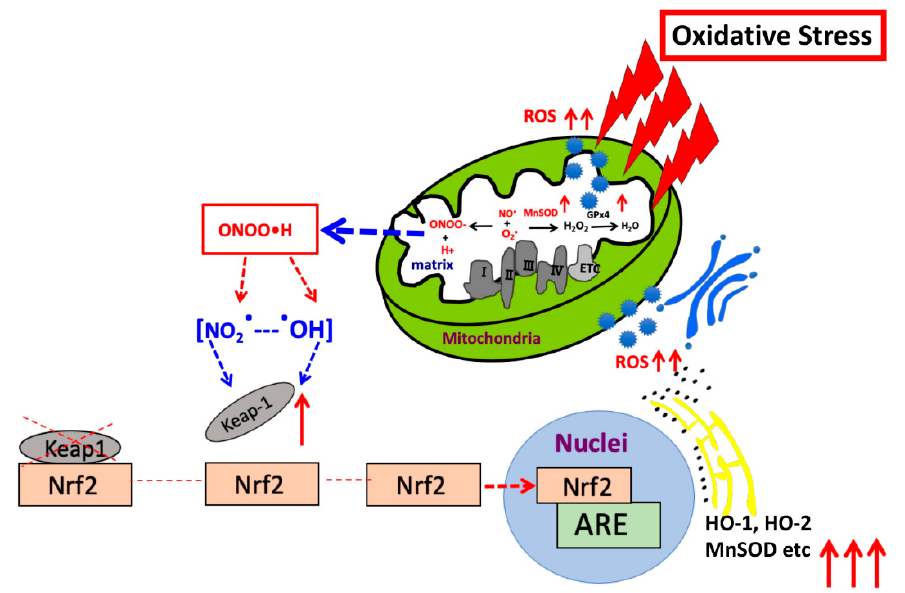
Figure 9. Schematic presentation indicating the mechanism by which mitochondrial ROS regulate Nrf2/Keap1 signaling in nucleus .